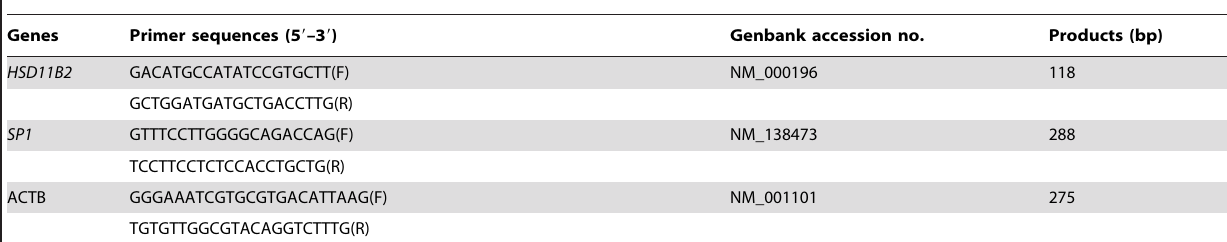
Table 1. Primer sequences used for PCR.